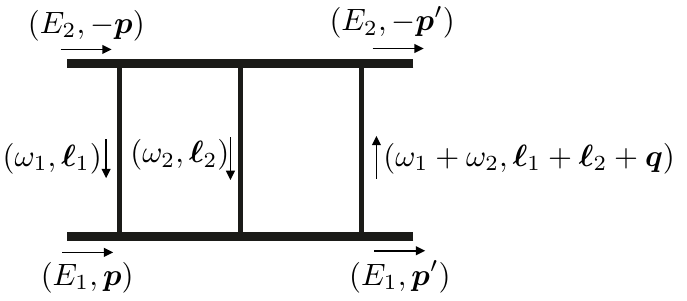
Figure 23 . The double-box